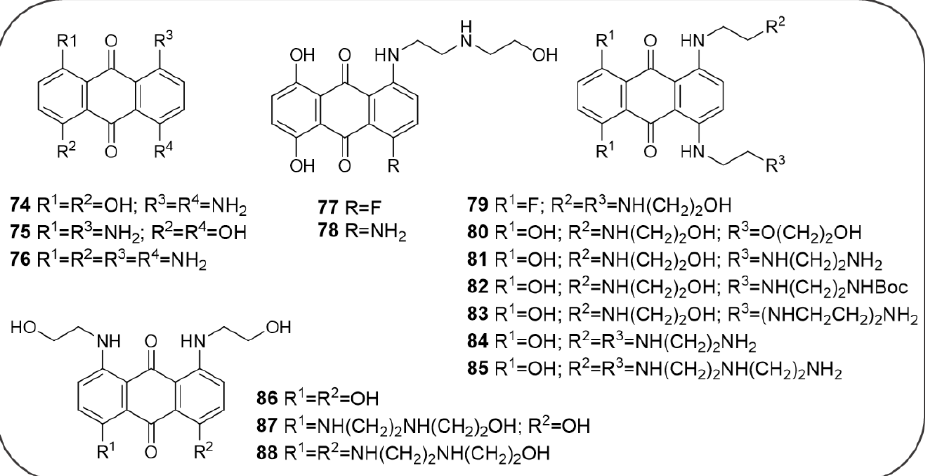
Figure 16. Yang et al. MTX analogues.